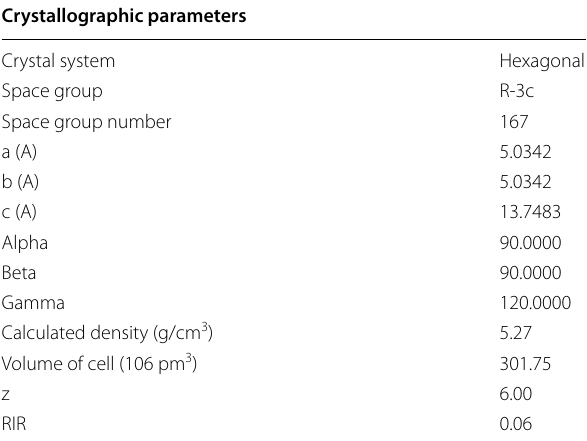
Table 1 Network parameters for the sample